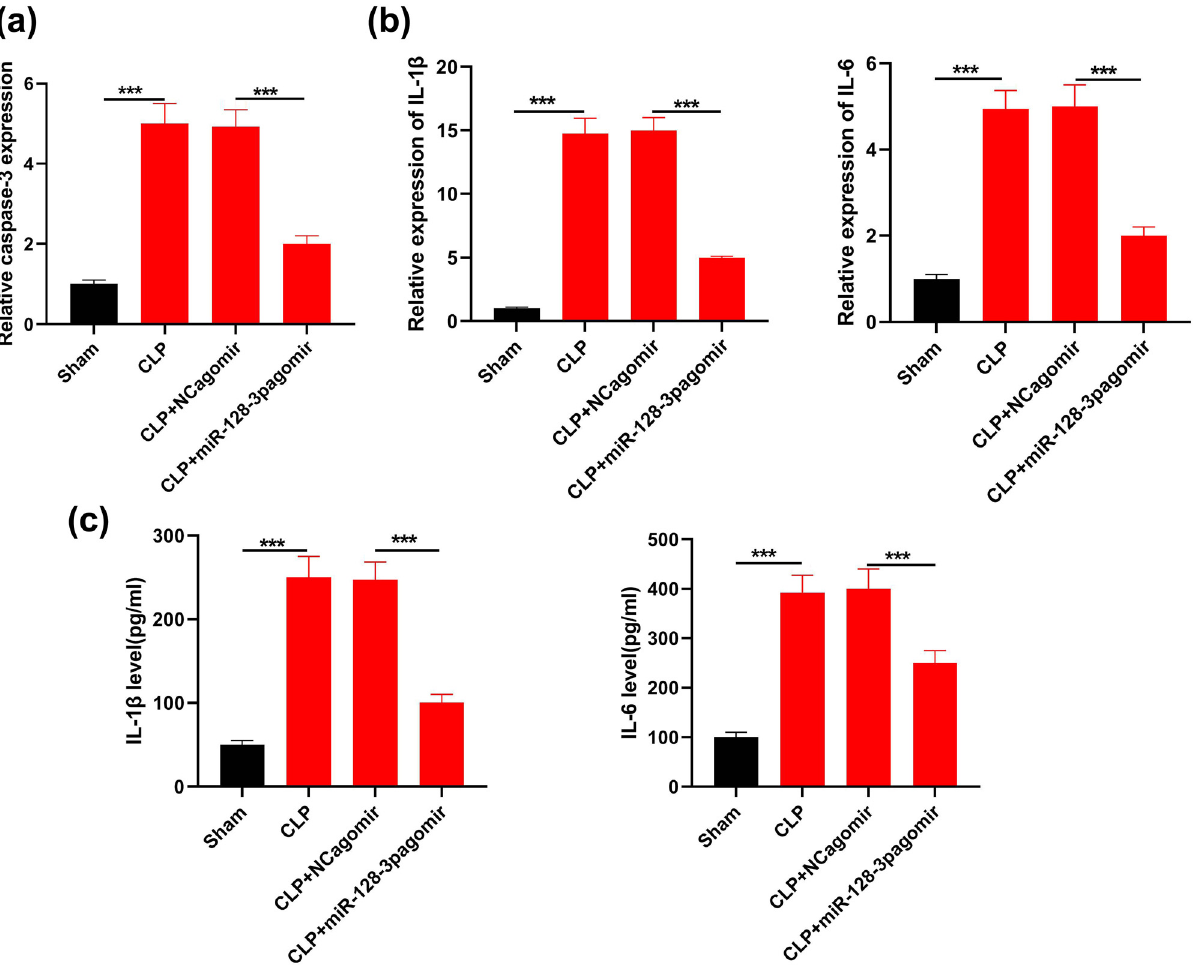
Figure 2: E ff ects of miR - 128 - 3p overexpression on cellular apoptosis and in fl ammation among pulmonary cells of mice models of sepsis resulting from CLP. ( a ) Caspase - 3 transcription activity in tissues with high miR - 128 - 3p expression was detected via caspase - 3 assay. ( b ) IL - 6 and IL - 1 β mRNA levels were measured through qRT - PCR. ( c ) IL - 1 β and IL - 6 were detected through ELISA. *** P <